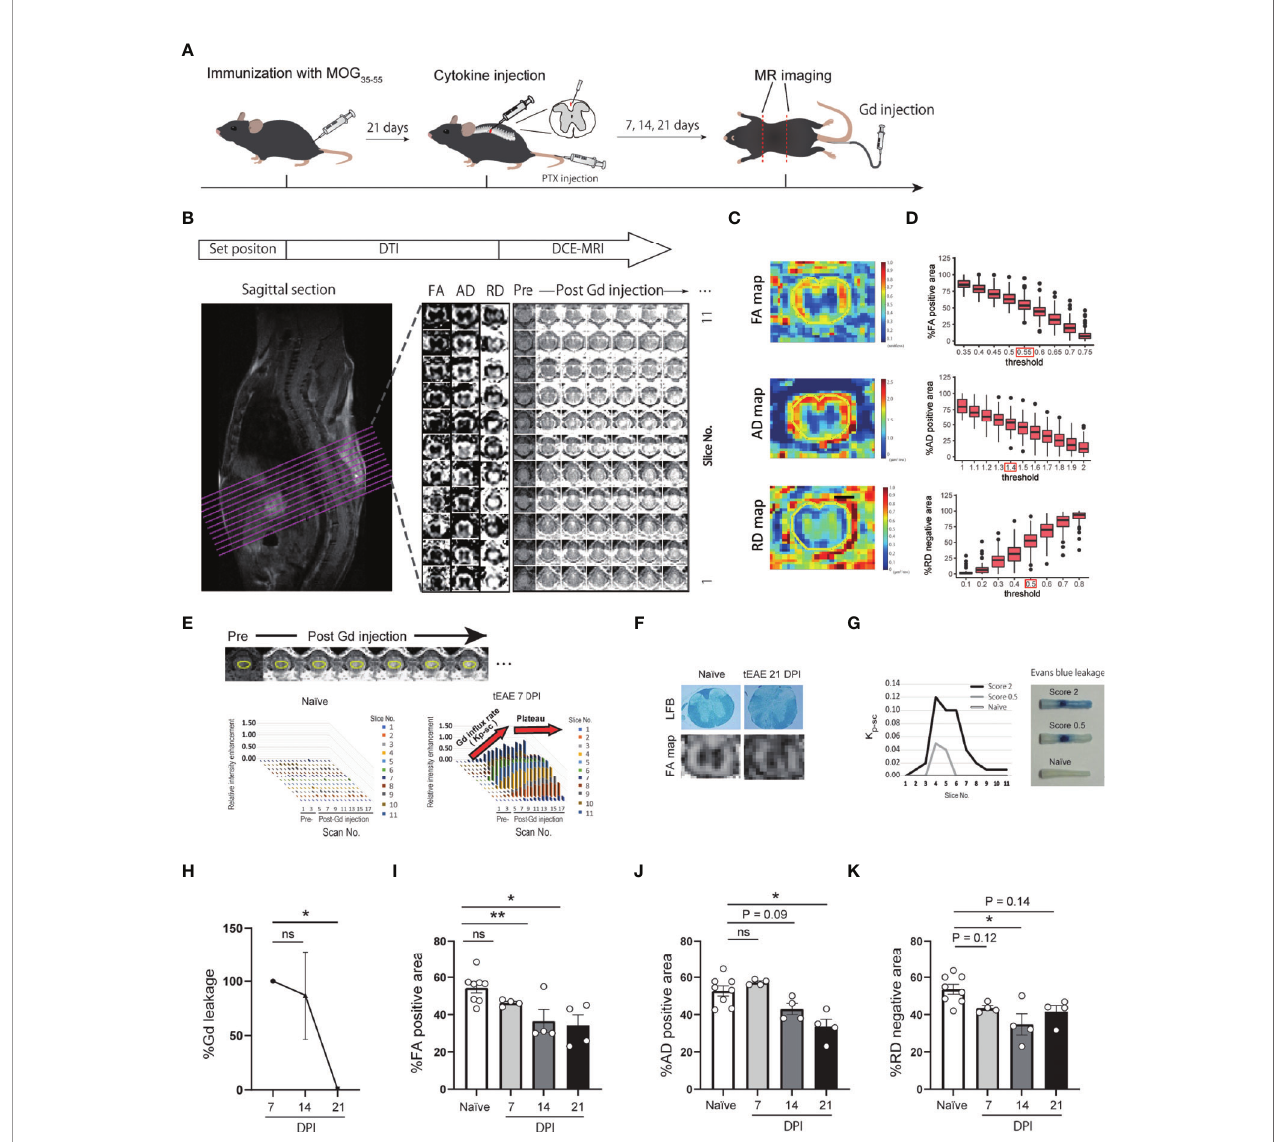
FIGURE 1 | Development of DCE-MRI and DTI quantitative analytical method. (A) Graphical representation of MR imaging of targeted EAE mice. (B) MRI analytical fl ow. (C) Representative images of FA, AD, RD maps and ROI setting. (D) Histogram of %FA positive area, %AD positive area, and %RD positive area in each threshold. (E) Representative images of DCE-MRI and ROI setting (upper panel). Plots indicate relative intensity enhancement of pre- and post-Gd injection in naïve and targeted EAE mice at 7 DPI (lower panel). Gd in fl ux into the spinal cord (Kp-sc) reach a plateau by 6 scans post-Gd injection. (F) FA map and LFB staining of spinal cord in naïve and targeted EAE mice at 21 DPI. (G) Kp-sc indicating the extent of Gd leakage into the spinal cord (left), and representative images of Evans Blue leakage into the spinal cord at 7 DPI (right) are presented. (H) Temporal change of the extent of Gd leakage. %Gd leakage at 14 and 21 DPI was calculated individually relative to the Gd leakage at 7 DPI. (n=4 for each timepoint, Dunnett ’ s multiple comparison test). (I – K) %FA positive area (I) , %AD positive area (J) , and %RD negative area (K) of naïve and targeted EAE mice at each timepoint (n=4, Dunnett ’ s multiple comparison test, compared to naïve mouse). Error bars represent the mean ± SEM. * p < 0.05, ** p < 0.01. ns, not signi fi